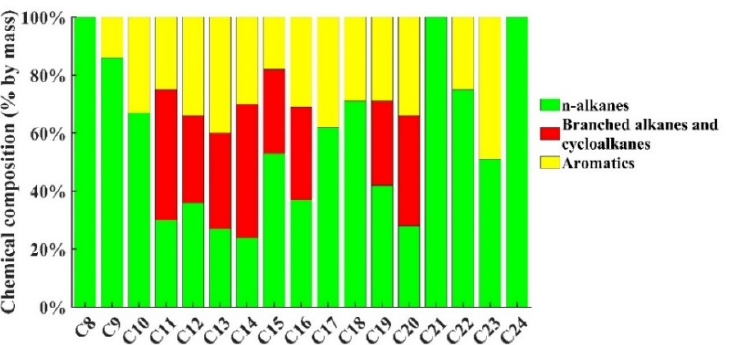
Figure 2. Distribution of n -alkanes, branched alkanes, cycloalkanes, and aromatic hydrocarbons versus the number of carbon atoms (t = 0 days).